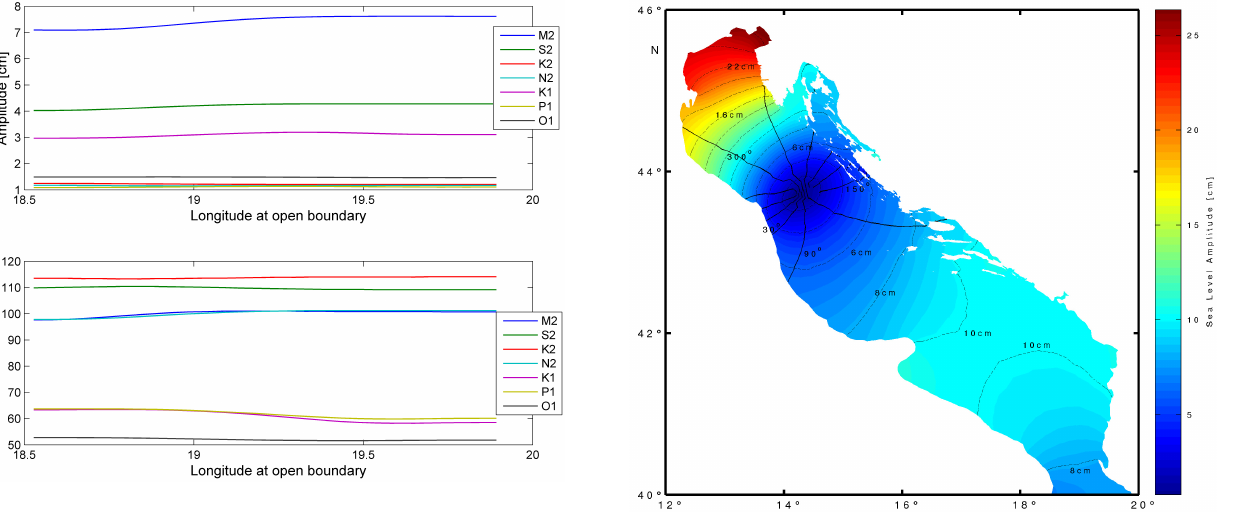
Fig. 4. Optimal boundary conditions for amplitudes (top) and phases (bottom) at the open boundary (Otranto strait).